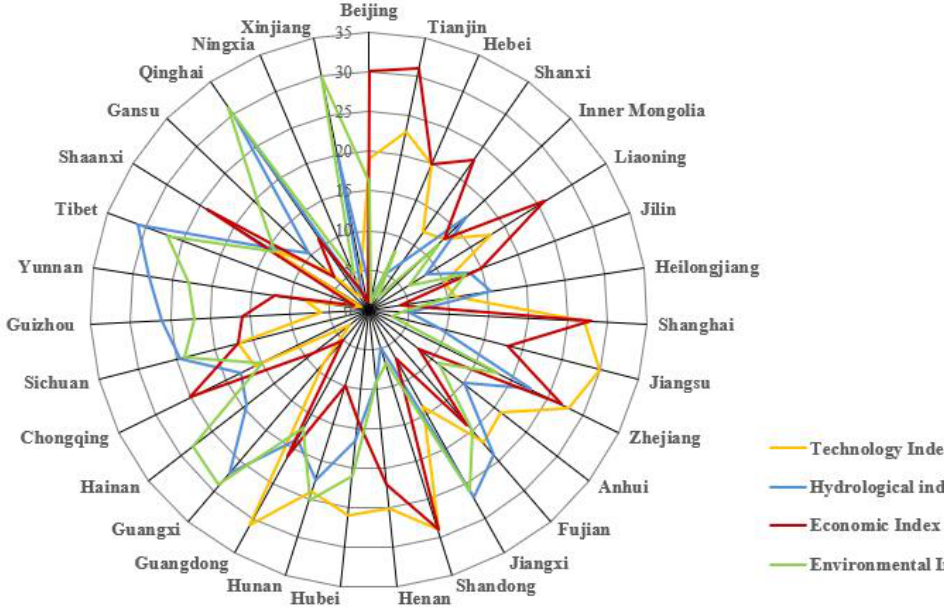
Figure 7. Ranking the distribution of regional evaluation indexes of the sustainability of water resources in 2015.